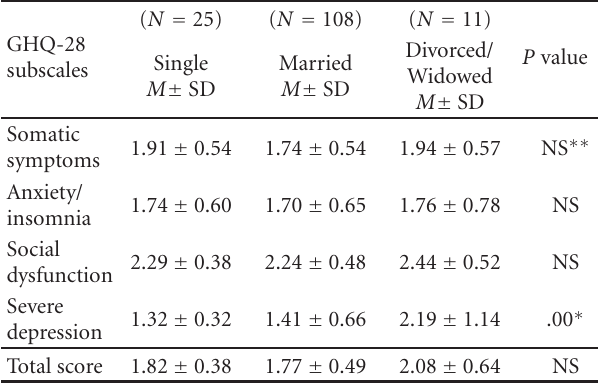
Table 5: Mean scores ± SD of GHQ-28 health subscales. One- way ANOVA showing di ff erences among singles, married, and